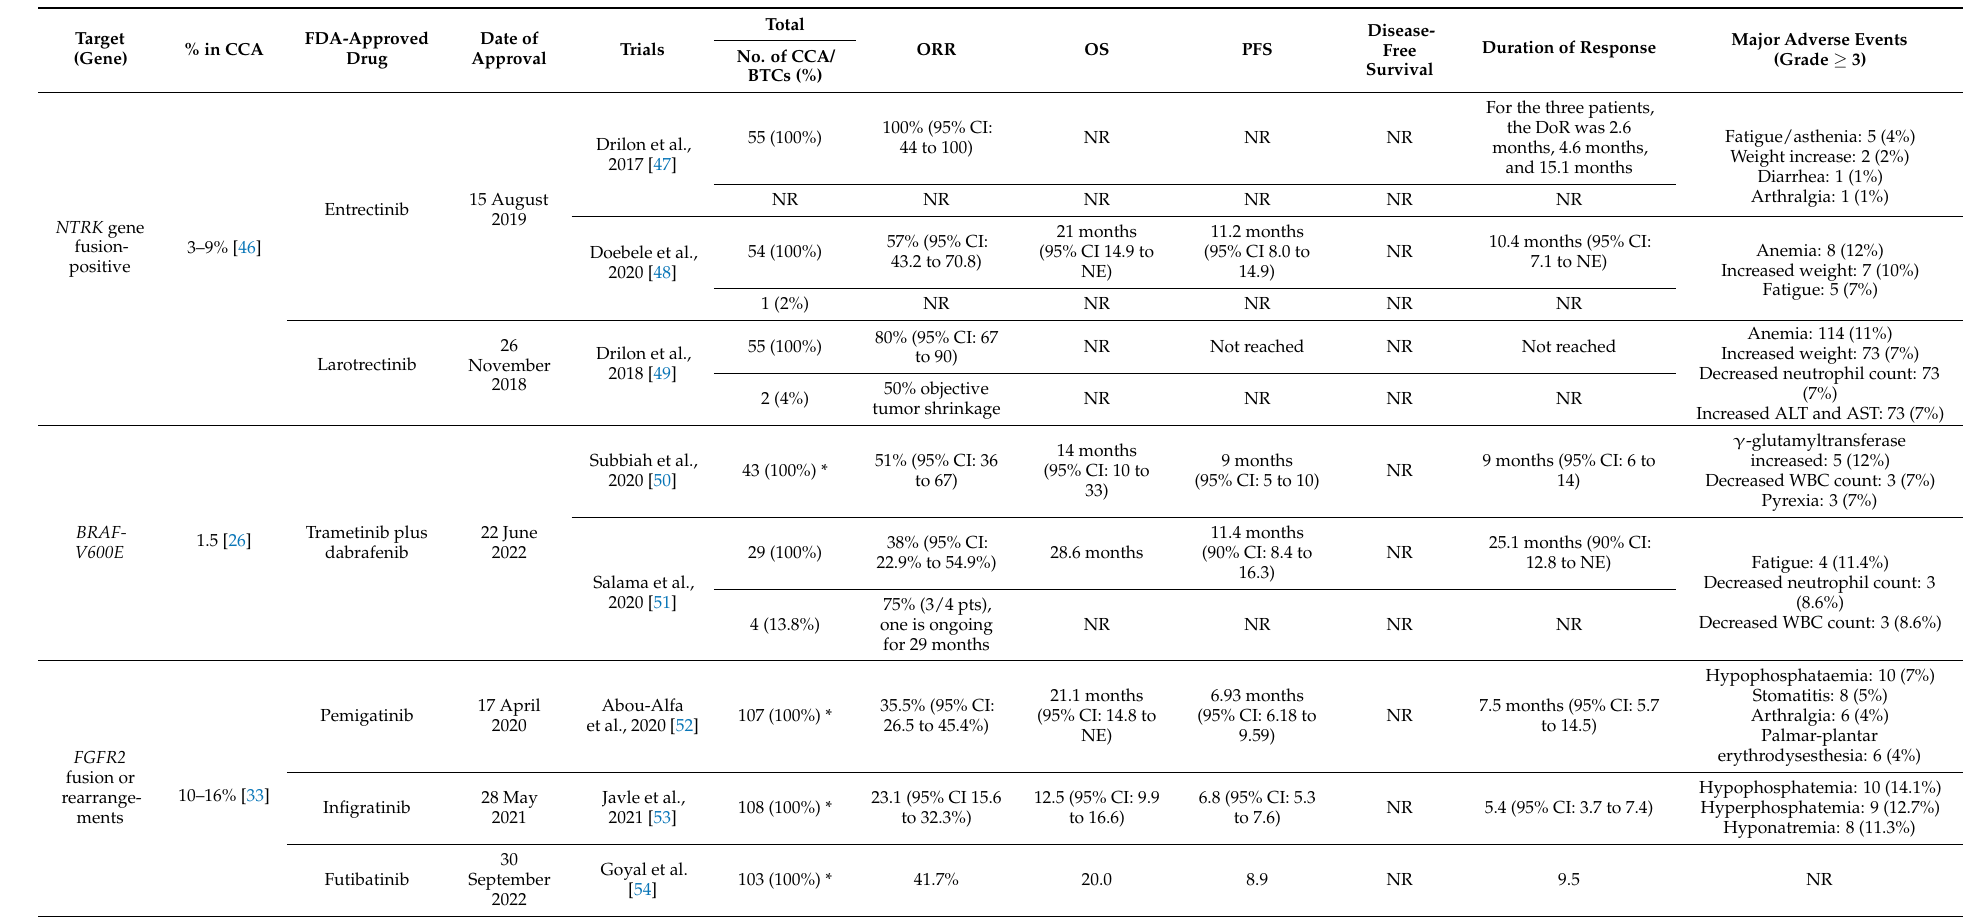
Table 2. Examples of targeted therapy